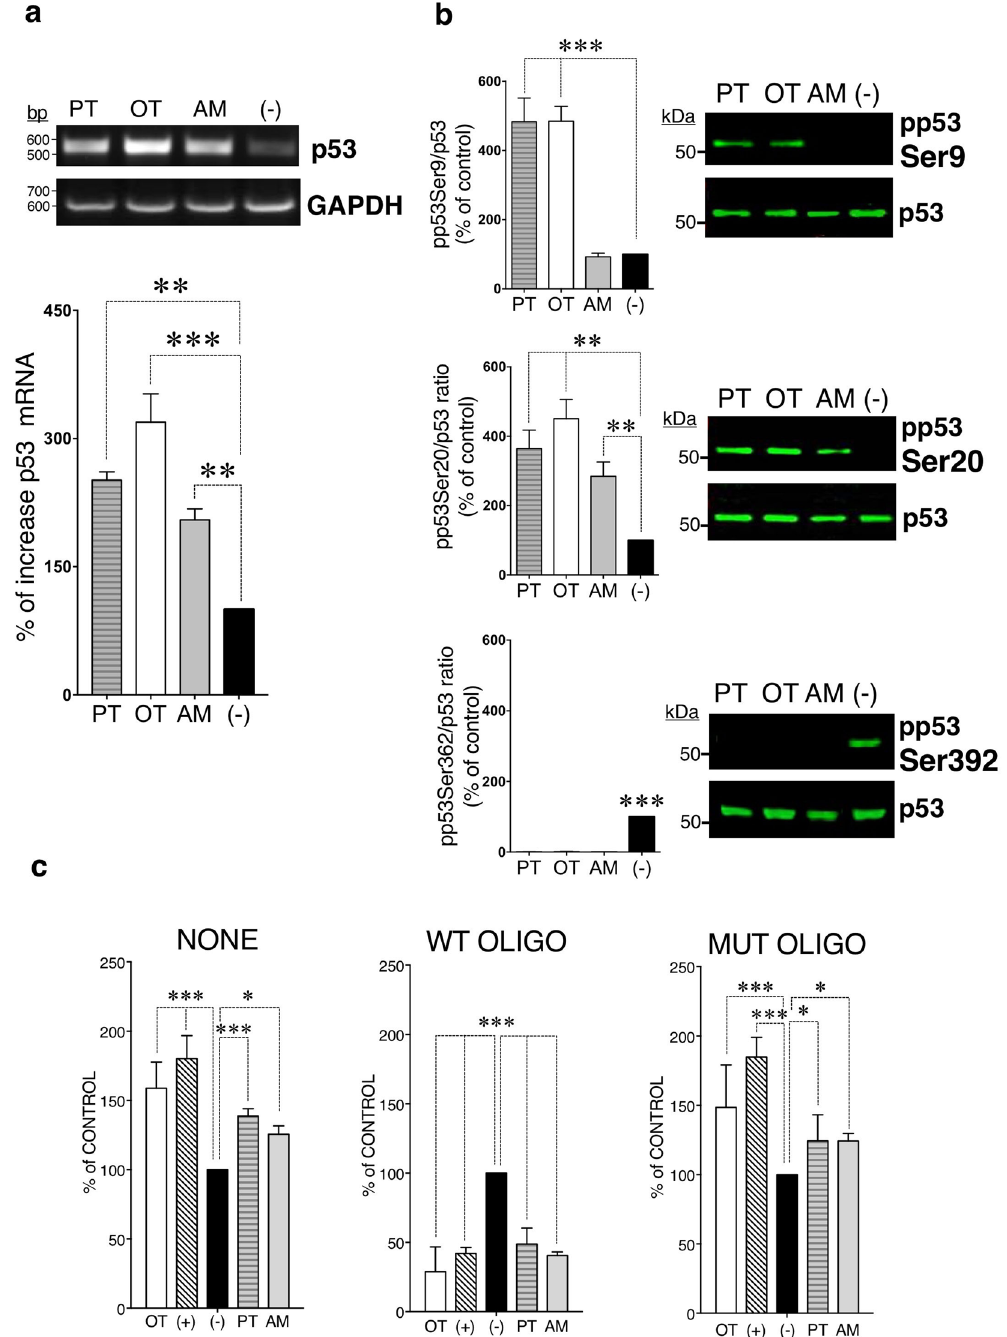
Figure 1. Effects of PT, OT and AM on the p53 gene expression, posttranslational modification and DNA- binding activity. Differentiated SH-SY5Y cells were treated with 100 μ M PT, OT and AM. ( a) p53 gene expression were determined by RT–PCR, normalized to GAPDH levels and mean ± SEM values ( n = 3) were expressed as a percentage of the response to non-treated cells ( − ). ( b) Western blots of phosphorylated p53 and total p53 were stained by appropriate antibodies. Data were normalized to total p53 and mean ± SEM values ( n = 3) were expressed as a percentage of the response to non-treated cells ( − ). ( c) The DNA-activity of p53 was determined by TransAM p53-DNA kit using nuclear extracts from cells treated with PT, OT, AM (NONE). Competitive binding experiments were performed by capturing of active p53 in nuclear extracts by wild type (WT OLIGO) or mutated oligonucleotide (MUT OLIGO) prior the binding assay. Non-treated cells were examined as negative control ( − ). MCF-7 nuclear cell extract treated with H 2 O 2 , provided with the TransAM kit, was used as a positive control ( + ). Data were calculated as percent of non-treated cells where the mean of its value was set to 100% (n = 3). Statistical analyses were performed using One way ANOVA ( a , b ) and Two-way RM ANOVA ( c ) followed by Bonferonni post-testing ( * P < 0.05, ** P < 0.01, * ** P <